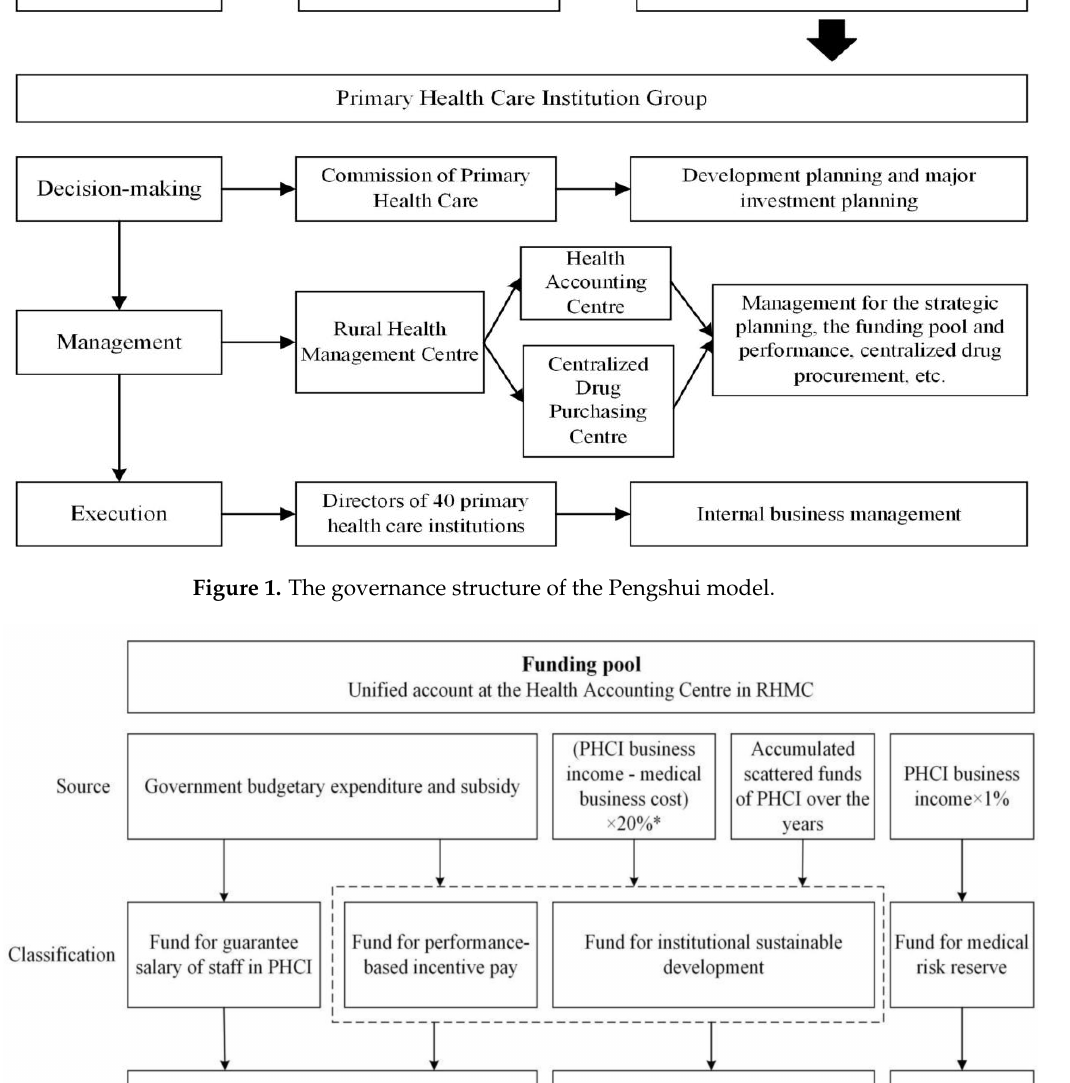
Figure 2. The source, classification, and usage of the funding pool in Pengshui County. * 20%: 10% is the percentage of the income from medical services (without pharmaceuticals), and another 10% is the percentage of income including pharmaceuticals. PHCI = Primary Health Care Institution, RHMC = Rural Health Management Centre.